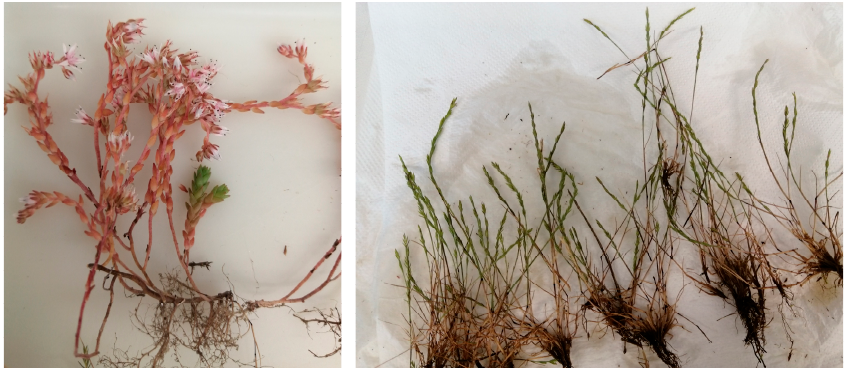
Figure 7. Two plant species collected in each sampling point of the Regoufe mining area. Sedum anglicum Huds. ( left ) and Lolium sp. ( right ).